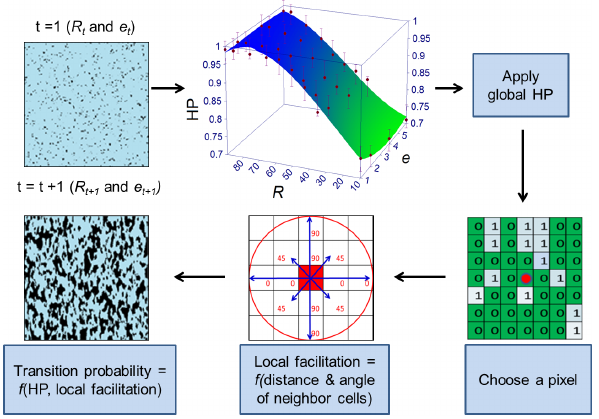
Figure 2. Schematic representation of steps in the cellular automata model of ridge and slough pattern development. The upper cen- tral panel is a third-order polynomial surface of hydroperiod (HP) vs. anisotropy ( e) and ridge patch density (% R ) ( R 2 = 0.98) based on numerical simulation of surface water flow using a hydrody- namic model (SWIFT2D; Schaffranek,